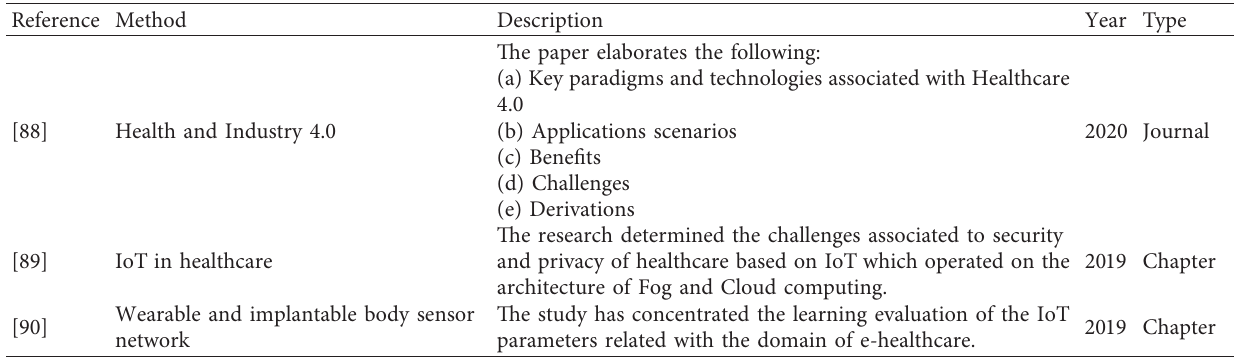
Table 3: Existing research in terms of the method/approach used along with the